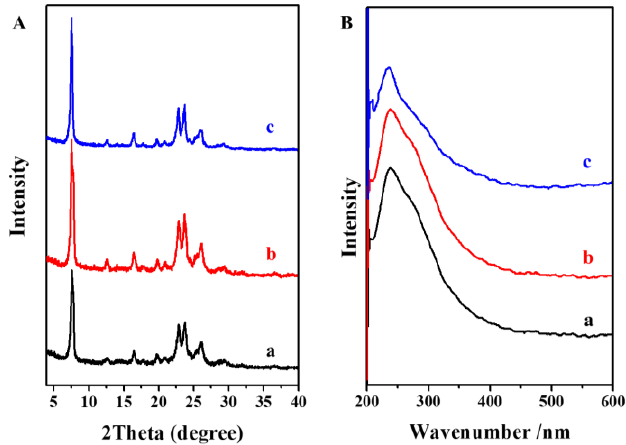
Figure 8. ( A ) XRD patterns and ( B ) UV-Vis spectra of ( a ) Zn-JHP-1, ( b ) Fe-JHP-1 and ( c ) Co-JHP-1.